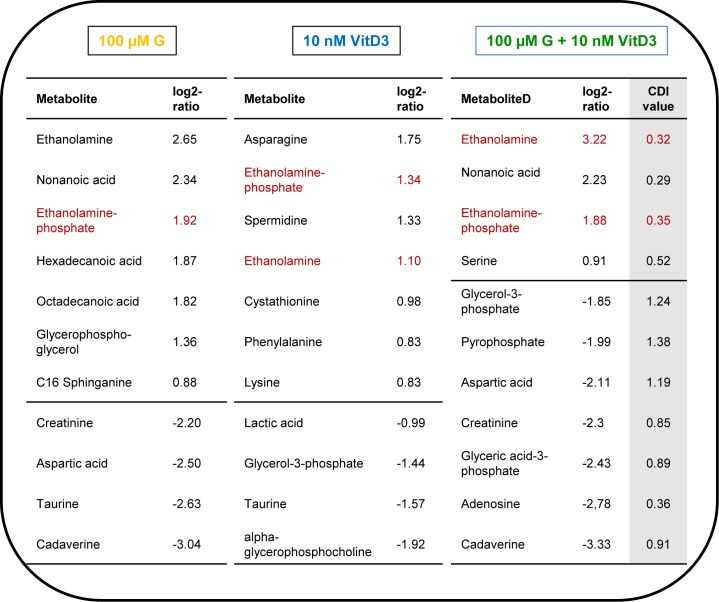
Ranking of metabolites which were significantly affected by genistein (G), calcitriol (VitD3) or the combination of both in comparison with control treatment (p ≤ 0.05; n = 4).Displayed were the log2 ratios. Notably, metabolites of the sphingolipid metabolism like ethanolamine and ethanolamine-phosphate were significantly upregulated. Synergistic effects of genistein and calcitriol were calculated by Chou-Talalay method, and displayed as CDI value. CDI < 1, CDI = 1, and CDI > 1 indicate synergism, additive effects, and antagonism, respectively.